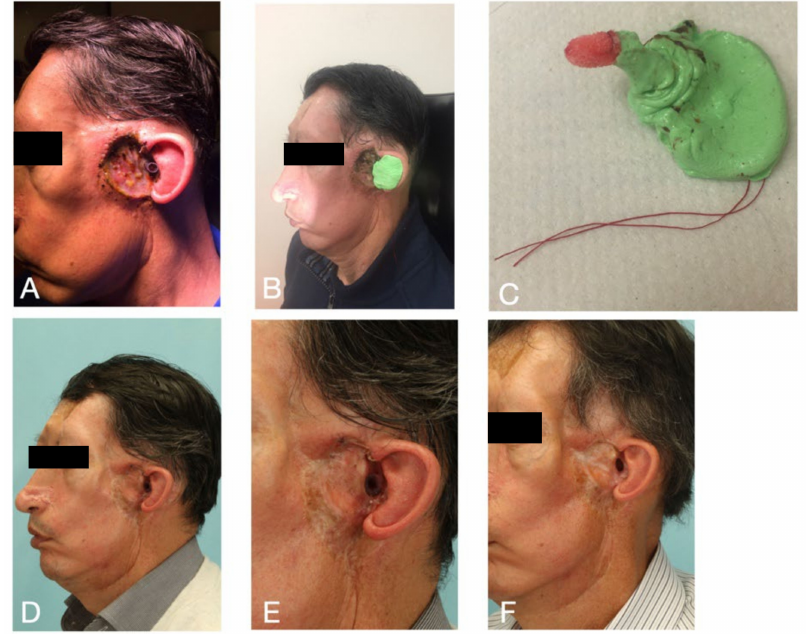
Figure 5. Extended indication for using Cerezen device to obtain an ear canal open till the end of healing process: ( A ) The situation after surgical removal of basal cell carcinoma with part of the external acoustic meatus, the ear canal opened with a plastic foil; ( B , C ) taking an impression to produce the in-ear device; ( D , E ) the situation one month after using the ear device; ( F ) after complete healing of the ear